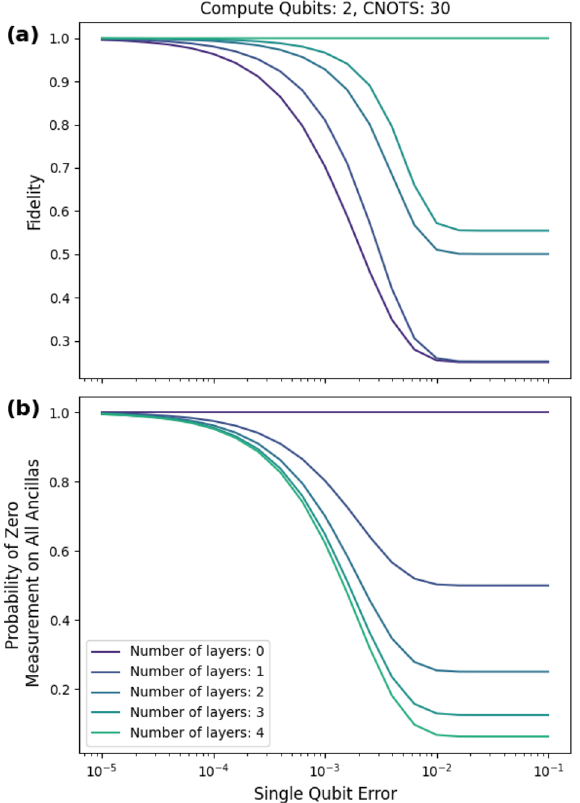
Figure 5. Example of checks that detect all errors. The upper bound on fidelity is saturated at four layers for this randomly generated Clifford input circuit consisting of two qubits and 30 cnot gates. We use depolarizing noise for the given noise model in Fig. 4a. The two-qubit error rate is ten times the single-qubit error rate. The single qubit-error rate ranges from 10 − 5 to 10 − 1 . At 10 − 1 , each cnot gate (acting on the compute qubits only) is followed by a two-qubit maximal depolarizing channel. Regardless, the postselected state is noiseless, as predicted by Theorem